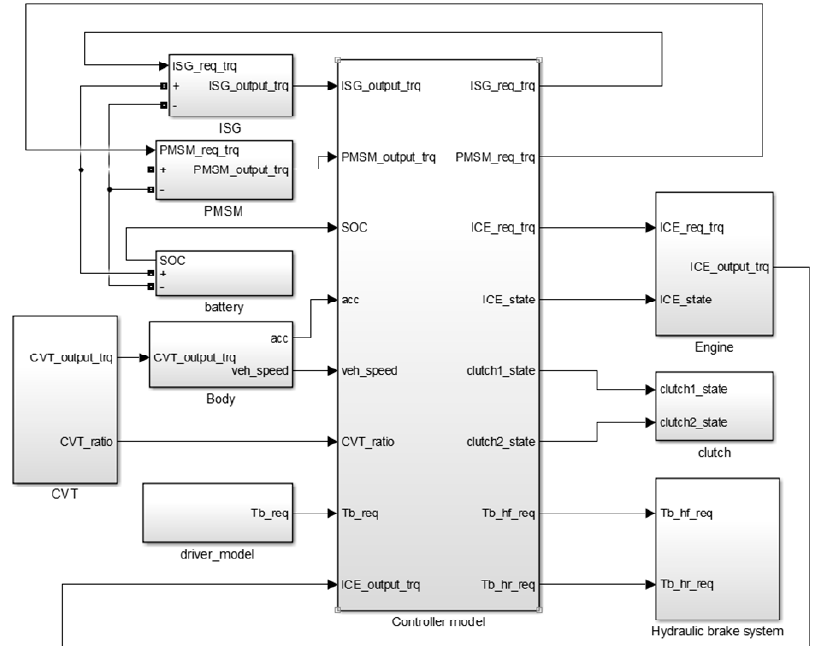
Figure 11. Vehicle simulation model based on Simulink.